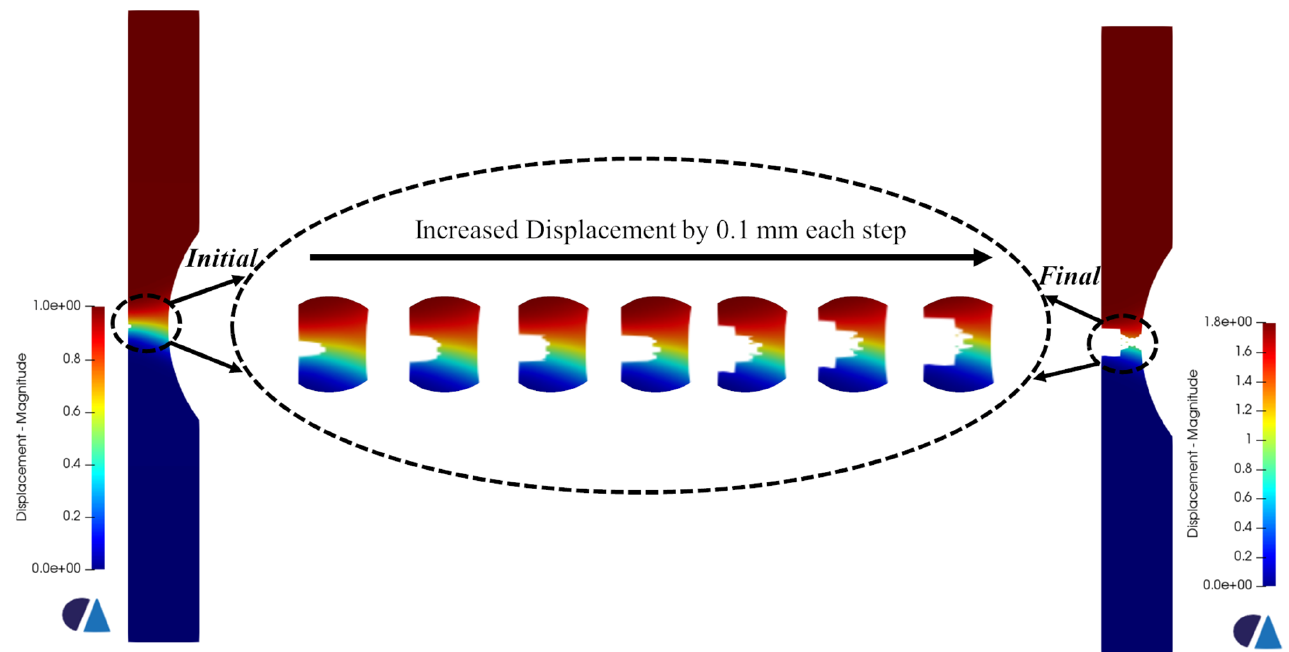
Figure 9. Fracture and failure progression in the round notched bar with an incremental increase in displacement. The displacement values are in mm.